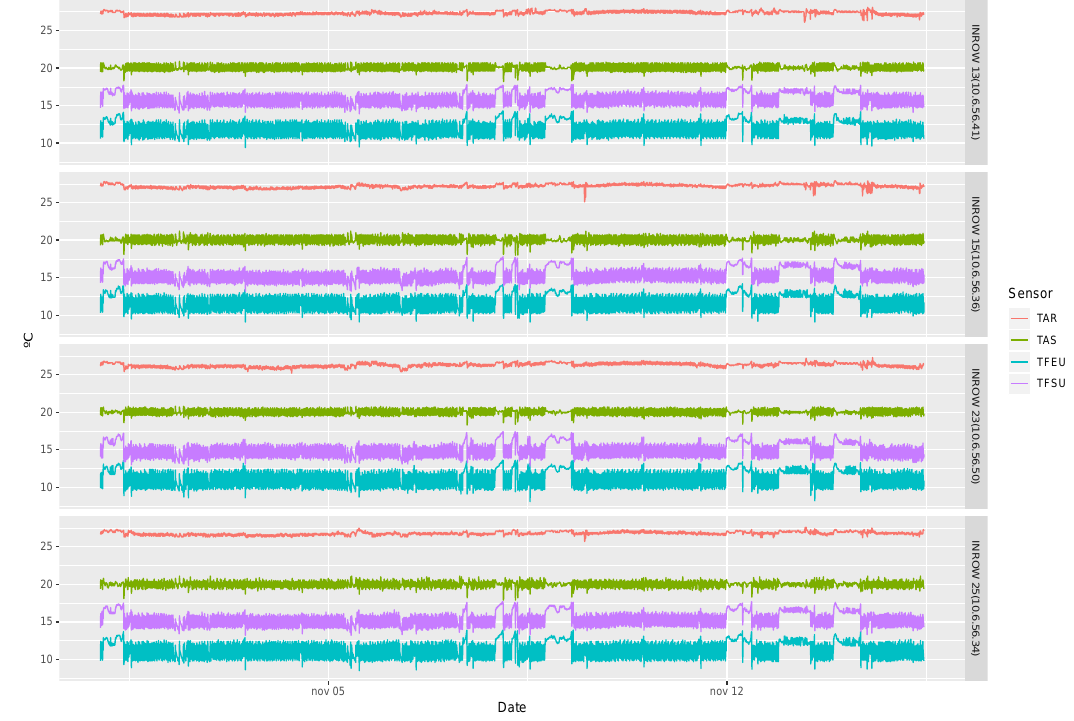
Figure 2. Signals of the sensors in the